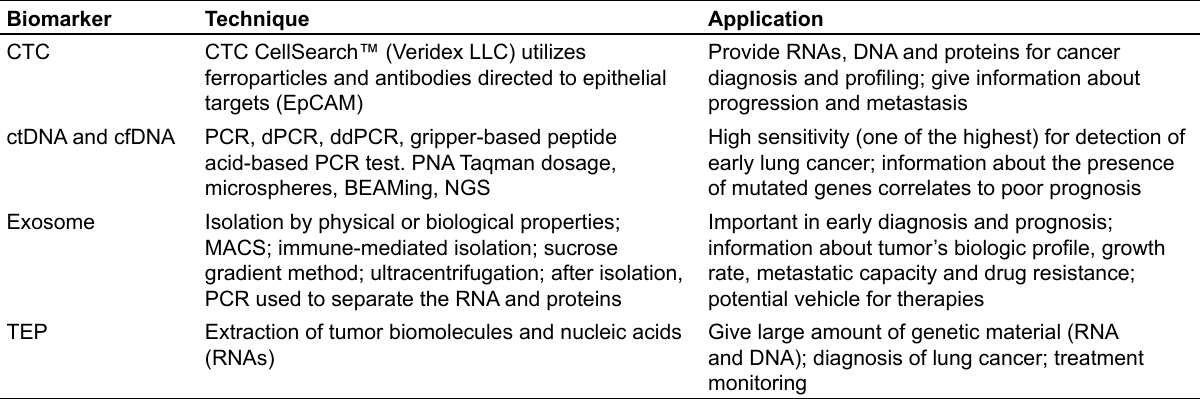
Table 1. Different characteristics of biomarkers in liquid biopsy